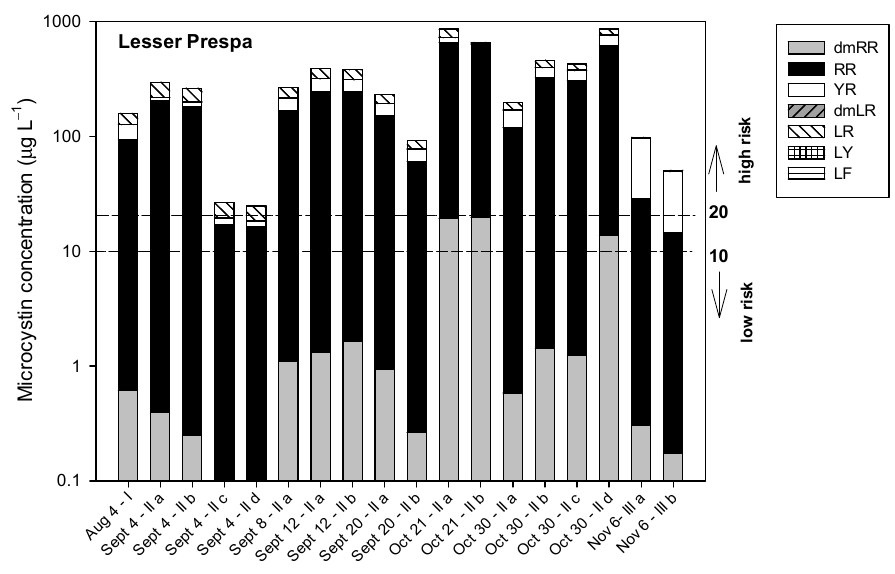
Figure 7. Concentrations ( µ g L − 1 ) of different microcystin variants measured in samples collected on 4 August 2014 (site I), Letters a, b and c indicate repeated samples taken from the same location. The dashed lines indicate levels below or above which the health risk associated with recreational activities may be low or high [41]. MC-variant LW and nodularin (NOD) were not